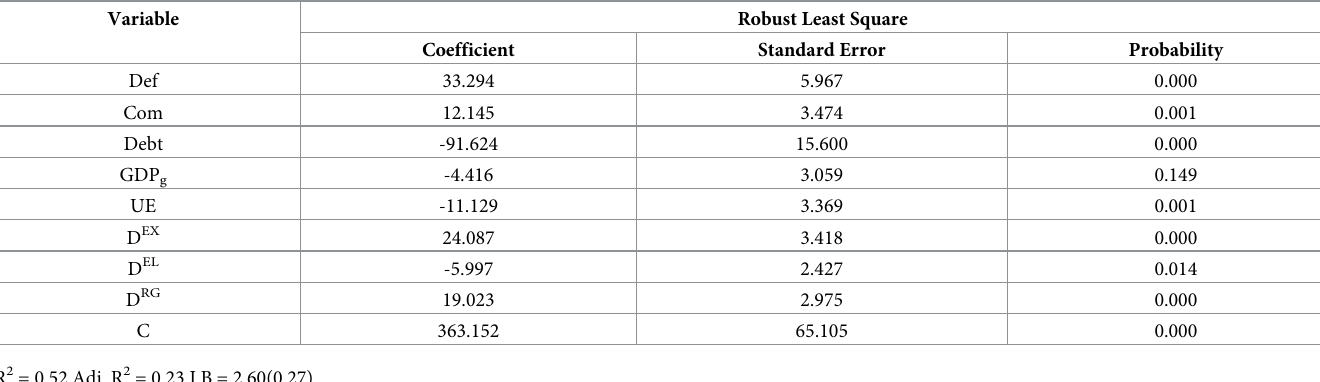
Table 6. Estimates of the success of fiscal adjustment.